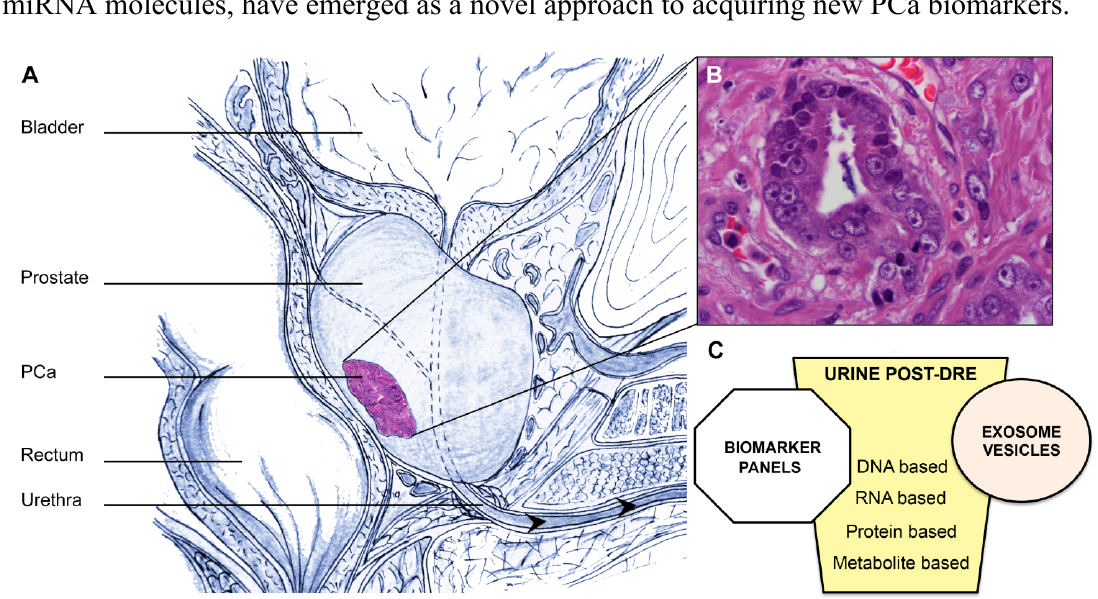
1. ( A ) Anatomical location of the prostate; ( B ) Prostate cancer cells; ( C ) Biomarkers found in urine. Based on their descriptions, biomarkers can be divided into the following groups: DNA-based, RNA-based, and protein-based. Of late, urinary exosomes, which are secreted vesicles that contain proteins and functional RNA and miRNA molecules, have emerged as a novel approach to acquiring new PCa